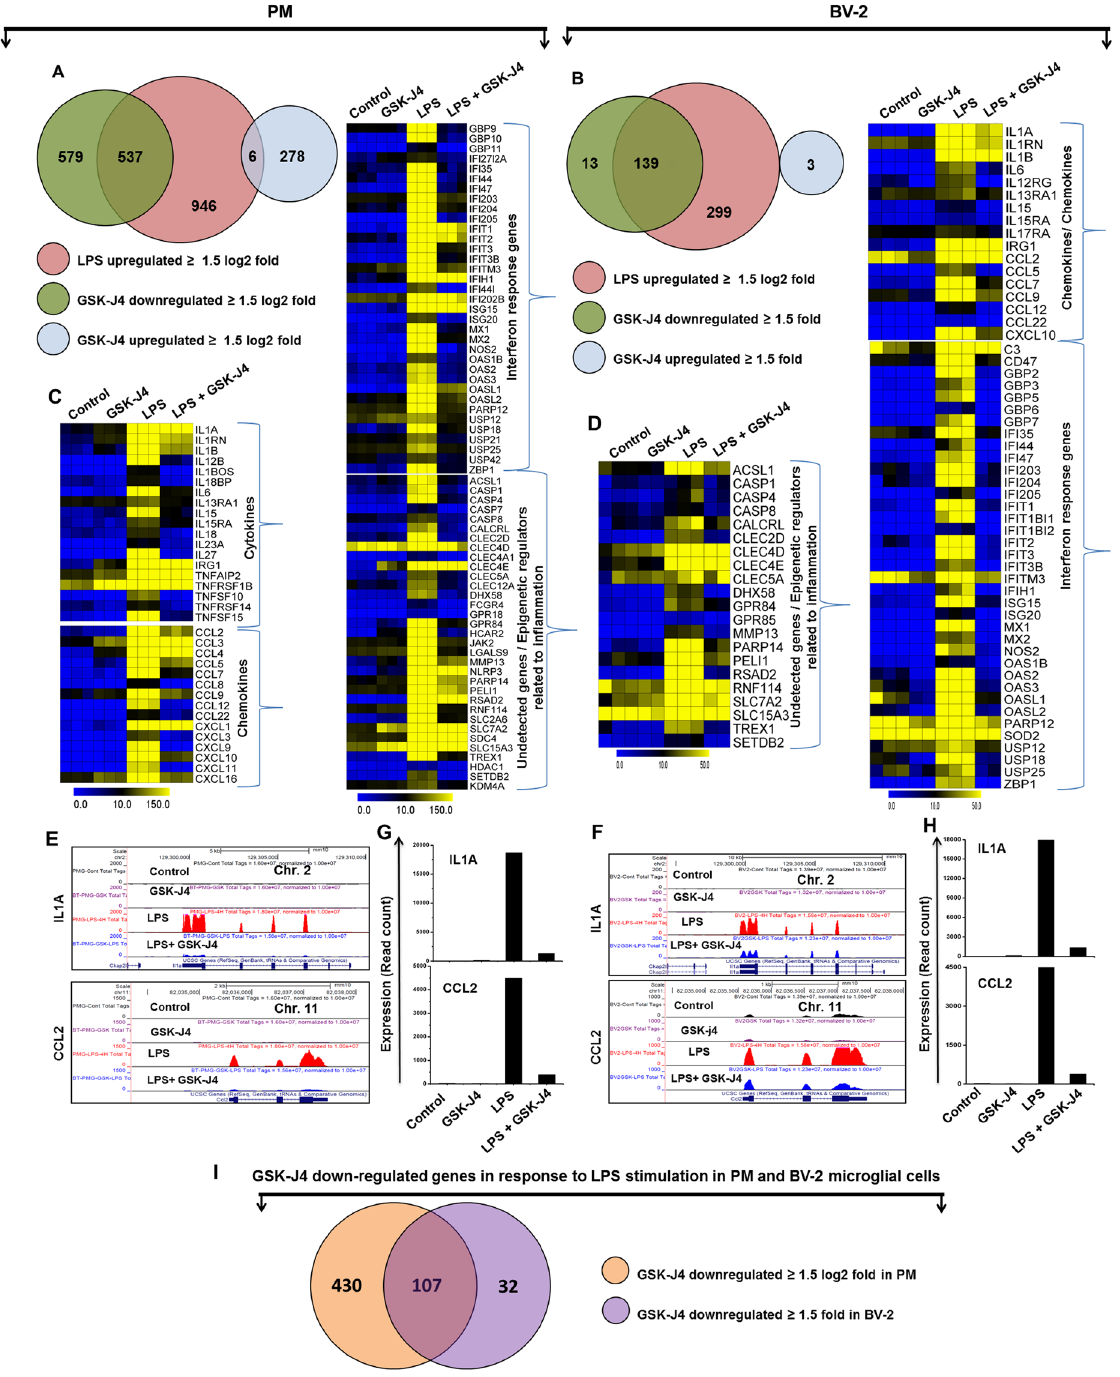
Figure 3. GSK-J4 suppresses a specific subset of LPS-inducible genes in PM and BV-2 microglial cells. ( A , B ) A Venn diagram displaying the number of LPS-inducible genes that were suppressed or up-regulated with GSK-J4 treatment at 4-h after LPS stimulation in the PM and BV-2 microglial cells respectively. ( C , D ) Heat map representation depicting the positive regulators of inflammatory genes (cytokines, chemokines, IRGs, and undetected genes related to inflammation) that were selectively down-regulated by GSK-J4 at 4-h after LPS stimulation in PM ( P ≤ 0.01, and log 2 -fold change ≥ 1.5) and BV-2 microglial cells ( P ≤ 0.01, and fold change ≥ 1.5) experiments, respectively. Heat maps were generated with the Multi Experiment Viewer (version 4.8) software. ( E , F ) UCSC Browser images representing the normalized RNA-seq read density in GSK-J4-down-regulated inflammatory genes at 4-h in the LPS-induced PM and BV-2 microglial cells compared with controls, respectively. ( G , H ) Transcript abundance (in read count) was evaluated using RNA-seq in GSK-J4-down-regulated inflammatory genes at 4-h in the LPS-induced PM and BV-2 microglial cells, respectively. ( I ) The area of overlap indicates the number of unique or shared GSK-J4 down-regulated genes after 4-h of LPS stimulation in PM and BV-2 microglial